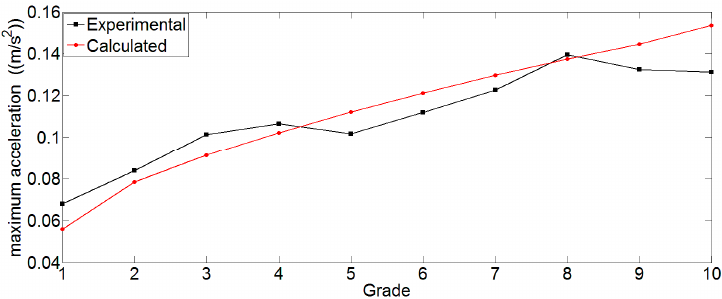
Figure 8. The comparison of the experimental and calculated maximum acceleration.